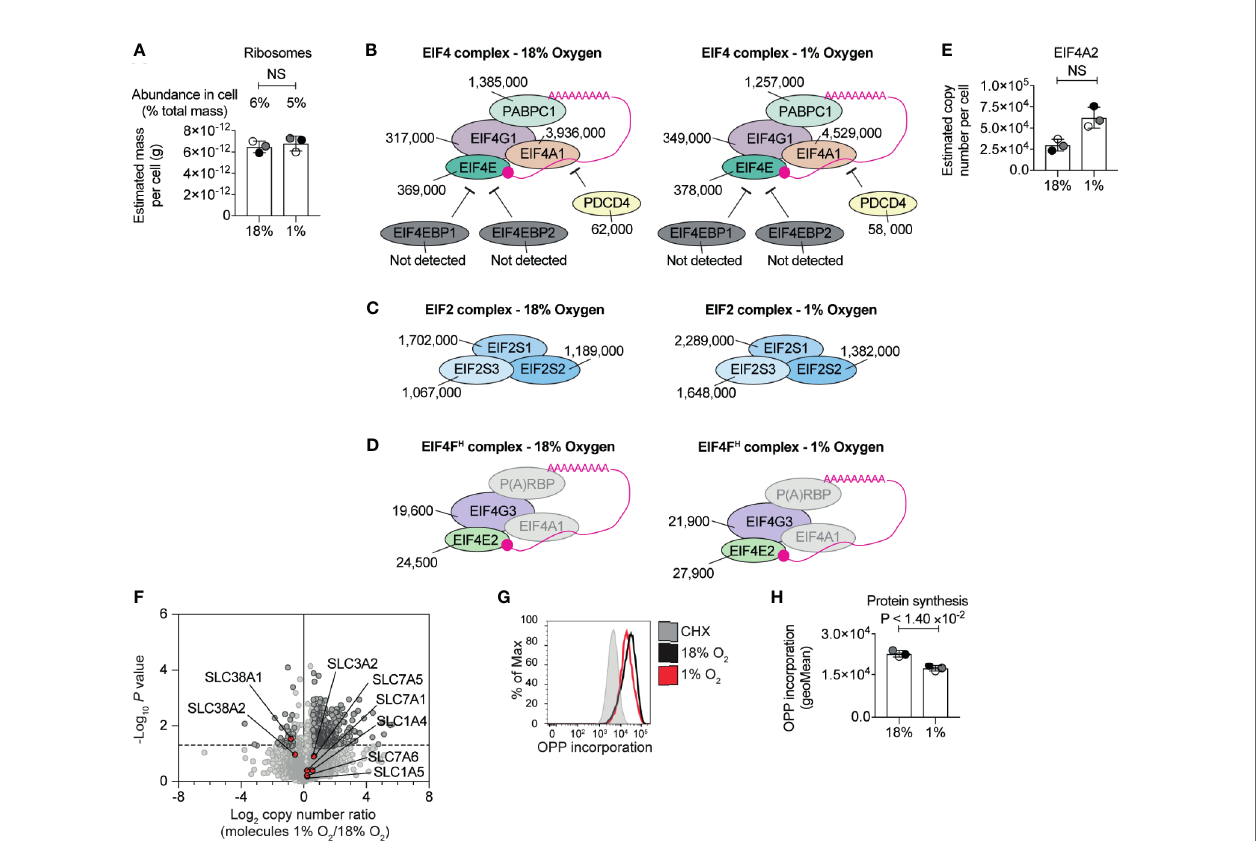
FIGURE 3 | Regulation of protein synthesis machinery by hypoxia. (A) Graph showing the estimated mass of proteins in a cell, calculated using the proteomic ruler, annotated with the KEGG pathway term “ ribosome ” for CTLs maintained in normoxia (18% O 2 ) or subjected to 24 hours of hypoxia (1% O 2 ). (B – D) Schematic representation of the EIF4 complex (B) and EIF2 complex (C) and the EIF4F H complex (D) . P(A)RBP stands for poly(A) RNA binding proteins. Average copy numbers for three biological replicates of CTLs maintained in normoxia or subjected to 24 hours of hypoxia are annotated alongside. (E) Copy numbers estimated from the proteomic data for EIF4A2. (F) Volcano plot showing the protein copy number ratio in hypoxic vs normoxic CTLs with amino acid transporters highlighted in red and annotated. (G, H) Protein synthesis of CTLs maintained in normoxia or subjected to 24 hours of hypoxia was evaluated using the puromycin analogue, OPP using a fl ow-cytometry-based assay. Normoxic CTLs were pre-treated with cycloheximide (CHX) for 30 minutes to block translation before the addition of OPP. Representative fl ow cytometry plots of one biological replicate of the OPP incorporation are shown in (G) and the geometric mean of the fl uorescence intensity for all three biological replicates acquired at the same time are shown in (H) . Data in (A) , (E, F) show three biological replicates; data in (B – D) show average values from three biological replicates. In bar charts, data points from biological replicates are shown and are colour matched, the bar shows the mean and the error bars show standard deviation. P values were calculated using a two-tailed paired t-test. Non-signi fi cant changes are marked